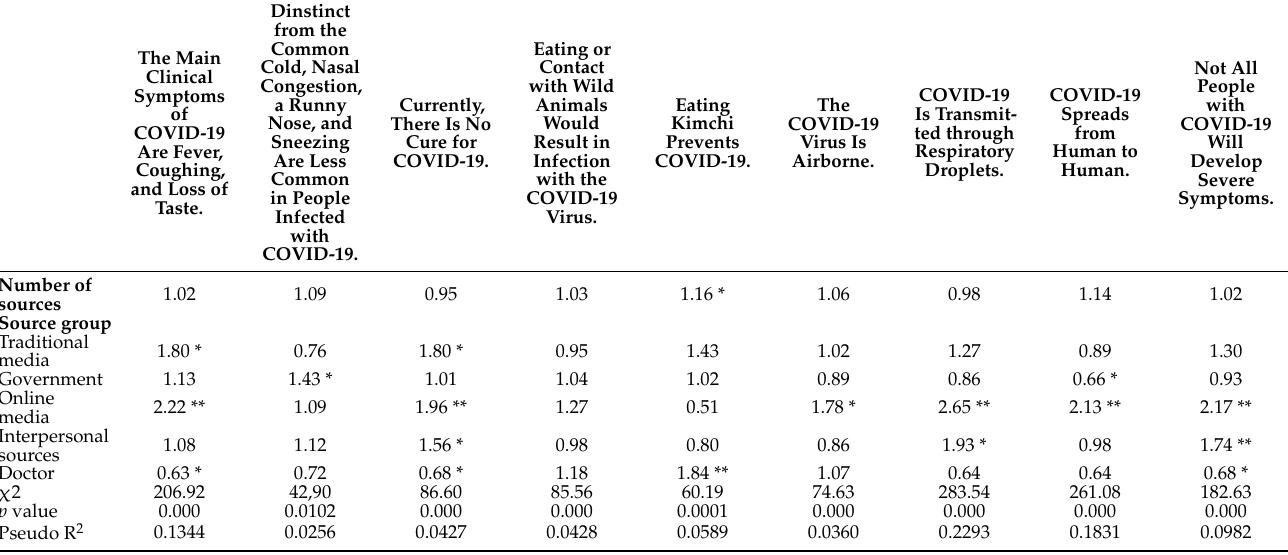
Table 5. Adjusted odds ratios of correct COVID-19 knowledge by information source ( n =